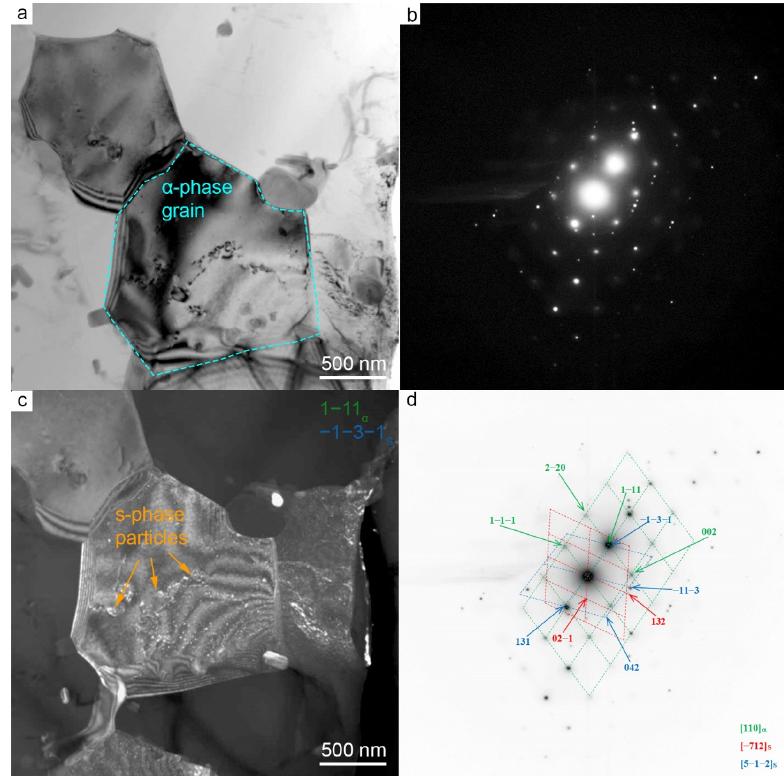
Figure 9. Microstructure of AA2024 in the SZ of FSW joint. Bright-field ( a ) and dark-field ( c ) TEM images, SAED ( b ) and SAED pattern indexing ( d ). Dark-field image taken in the group of reflections: 1 − 1 − 1 α & − 1 − 3 − 1 S .